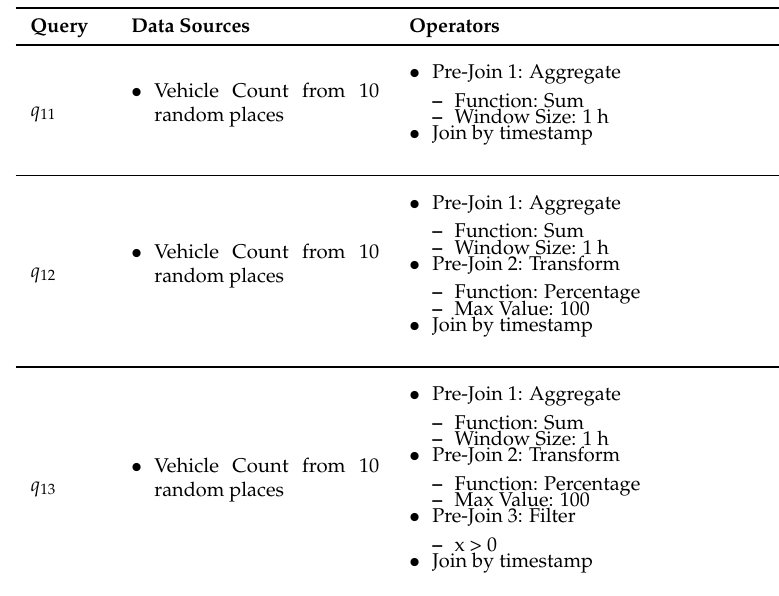
Table 2. List of queries for the benchmark experiment.